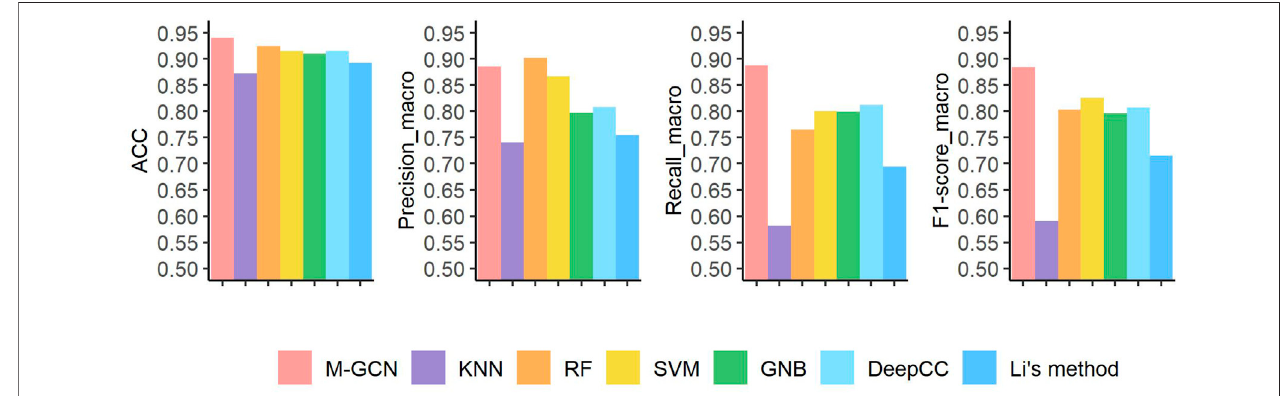
FIGURE 3 | Prediction performance under four evaluation metrics of seven methods in the BRCA dataset. Pink bar represents the fi nal performance of M-GCN; purple bar, orange bar, yellow bar, and green bar refer to the performance of KNN, RF, SVM, and GNB, respectively. Light blue bar is for the performance of DeepCC, and dark blue bar is for the performance of Li ’ s method.